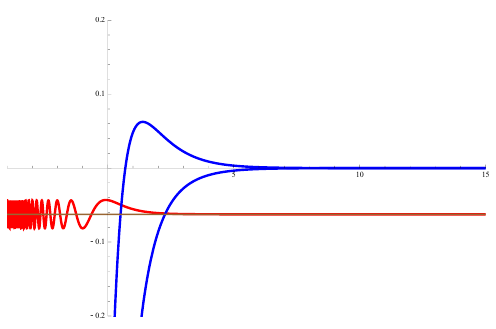
Figure 11 . Blue: Morse potential. Red: discrete state wavefunction solution Re ( g ( φ )) for νλ < 0 and with the energy variable k 2 / 4 = − 1 / 16